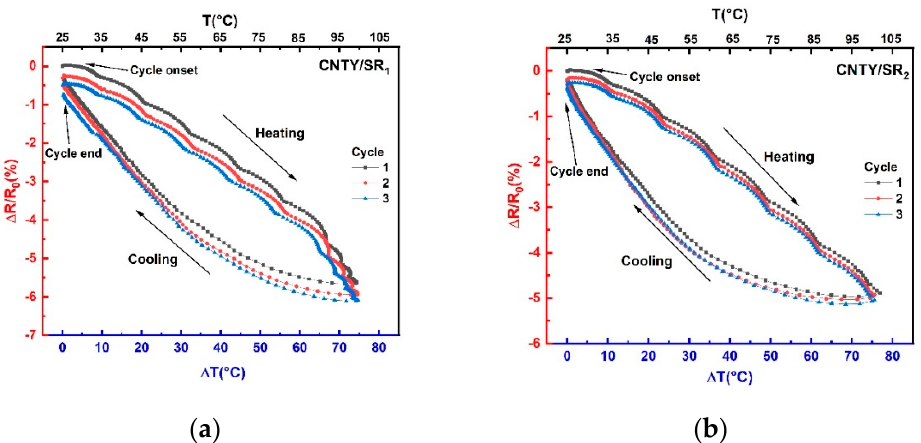
Figure 7. Cyclic thermoresistive response (fractional change in electrical resistance versus tem- perature) above RT of: ( a ) CNTY/SR1; ( b ) CNTY/SR2. ture) above RT of: ( a ) CNTY/SR1; ( b )